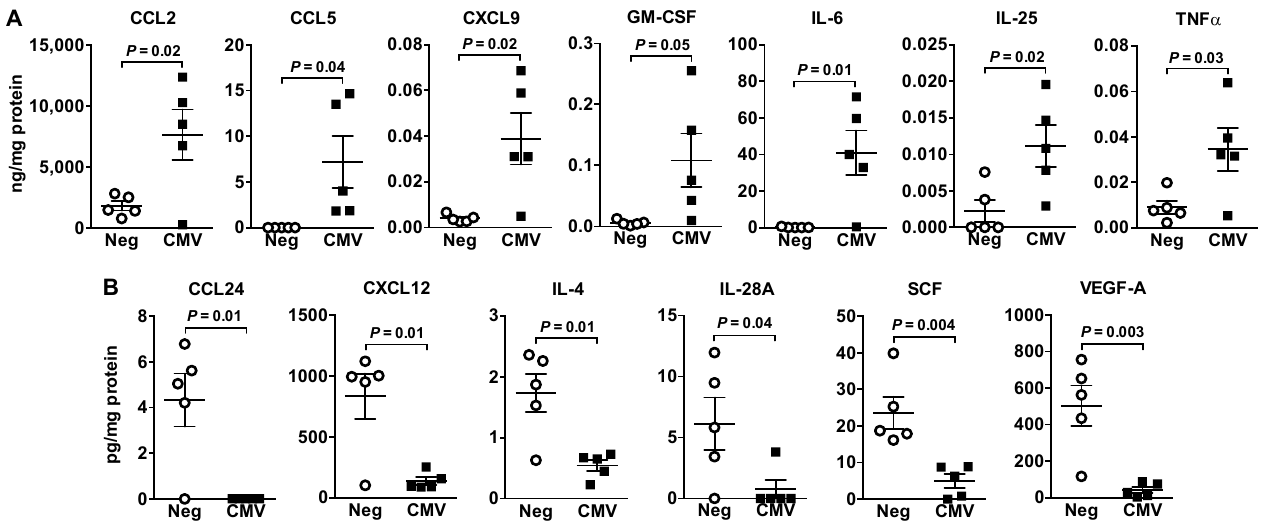
Figure 5. Secretion of pro and anti-inflammatory cytokines/chemokines from infected and uninfected HEL299 fibroblasts. Cells were exposed to 1 MOI HCMV or filtered control (Neg) for 48 h. The concentrations of 71 cytokines/chemokines/growth factors were analyzed in the culture media and those significantly increased ( A ) or decreased ( B ) are illustrated. Results are means ± SEM from five independent experiments. P ‐ values were calculated by unpaired Student’s t ‐ test.